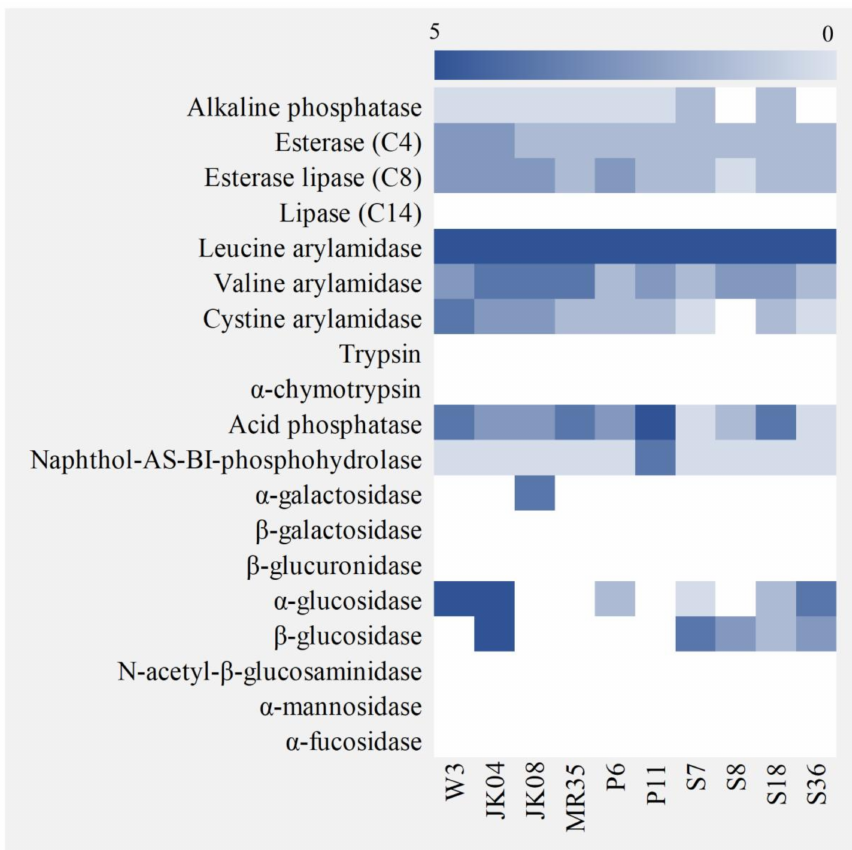
Figure 1. Heatmap of enzymatic activities of Saccharomyces cerevisiae W-3 and non- Saccharomyces yeasts isolated from various food materials. All activities were determined using an API ZYM kit. W-3, Saccharomyces cerevisiae W-3; JK04, Wickerhamomyces anomalus JK04; JK08, Torulaspora delbrueckii JK08; MR35, Starmerella bacillaris MR35; P6, Candida quercitrusa P6; P11, Pichia kluyveri P11; S7, Hanseniaspora vineae S7; S8, H. uvarum S8; S18, Candida railenensis S18; S36, Metschnikowia pulcherrima